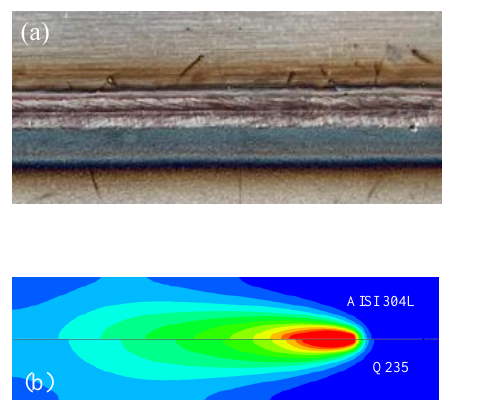
Figure 4. Top weld and bottom weld for laser butt welding of AISI 304L and Q235 steels.